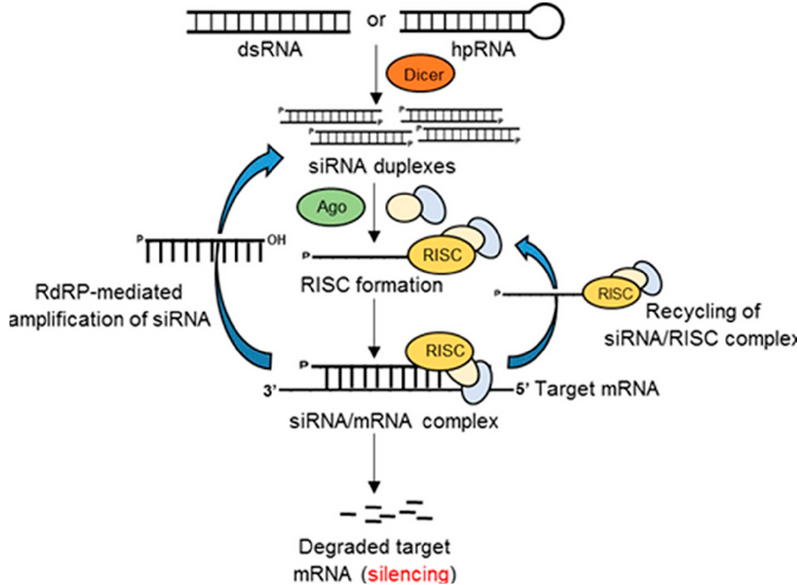
Figure 6. Graphic of the mechanism of the RNAi in eukaryotic cells [63].